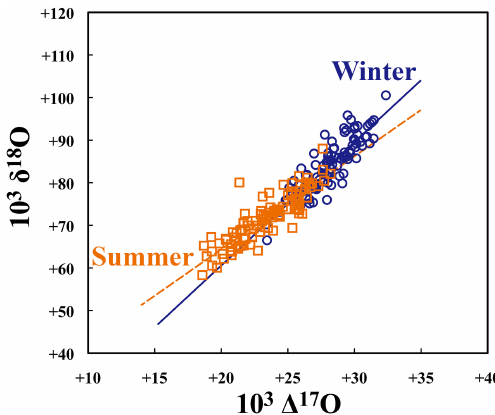
Figure 4. Relationship between (cid:49) 17 O and δ 18 O for atmospheric ni- trate in wet deposition. The errors were smaller than the size of the symbols. The blue circles represent data for winter, from November to March, whereas the orange squares represent data for summer, from April to October. The blue solid and orange dashed lines rep- resent the least-squares fitted lines to the data of winter and summer